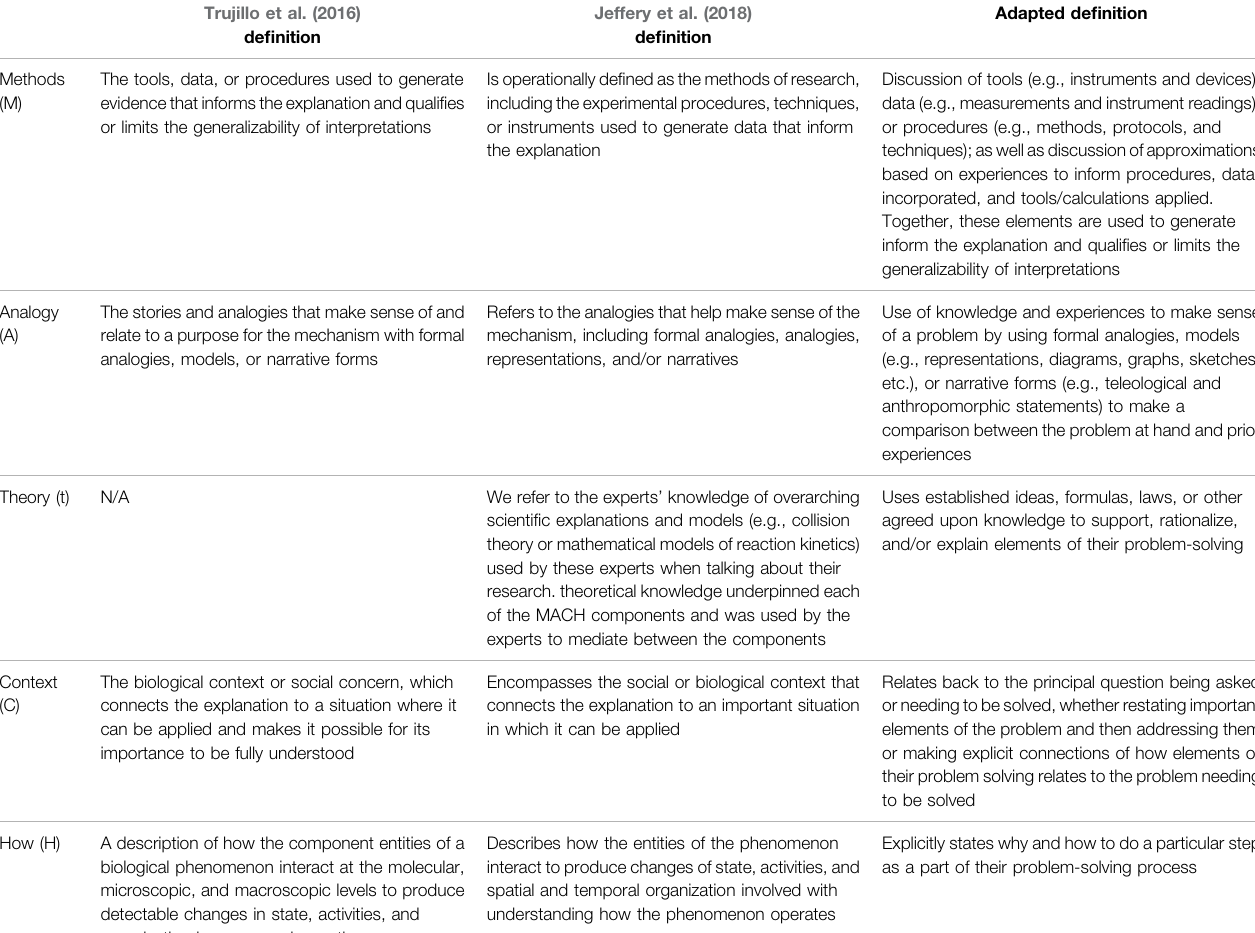
TABLE 2 | Revised MAtCH component de fi nitions compared with Trujillo et al. (2016) de fi nitions and Jeffery et al. (2018) de fi nitions Trujillo et al. (2016) de fi